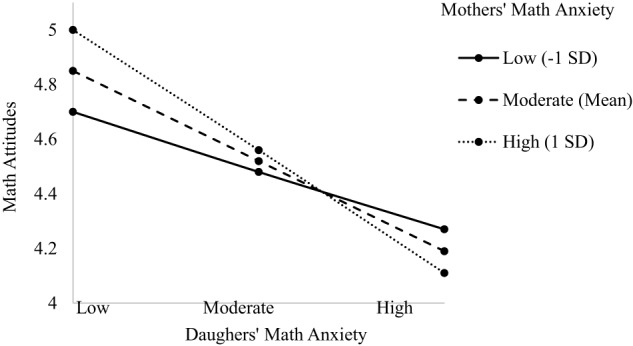
Three-way interaction predicting math attitudes from Mothers' and Daughters' math anxiety.